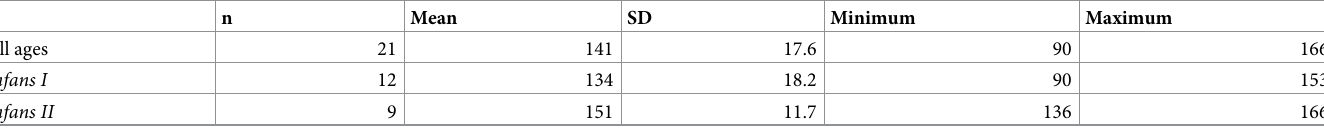
Table 3. Upper second deciduous molar occlusal topography (Mesial interior slope angle—(MISA) in degrees).